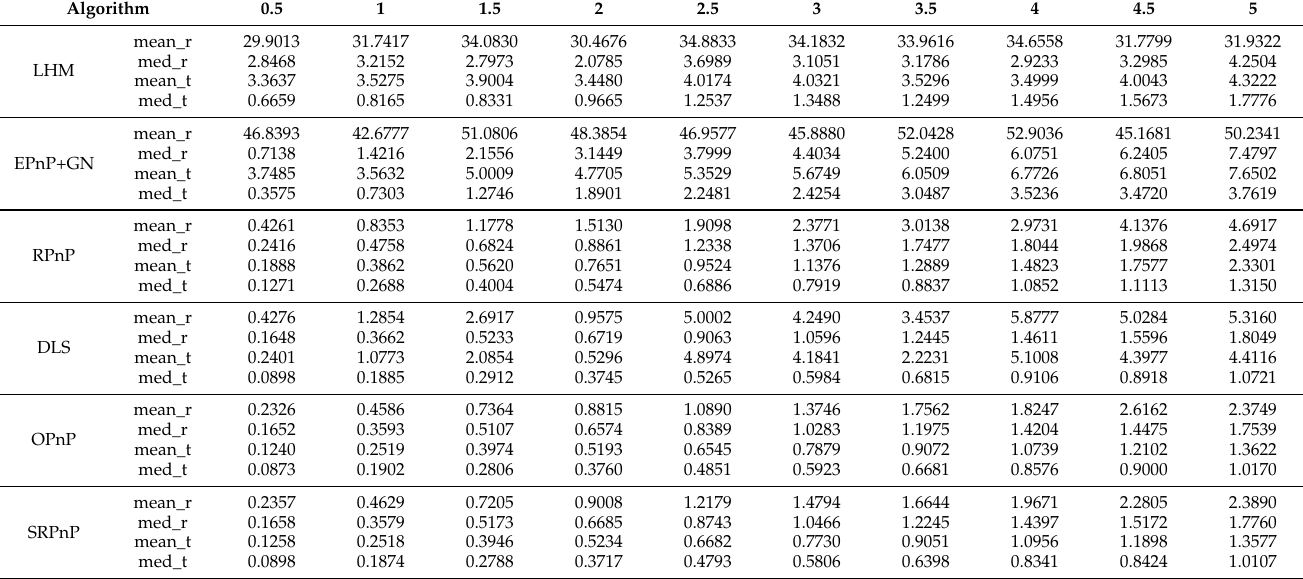
Table A5. Error comparison in Planar